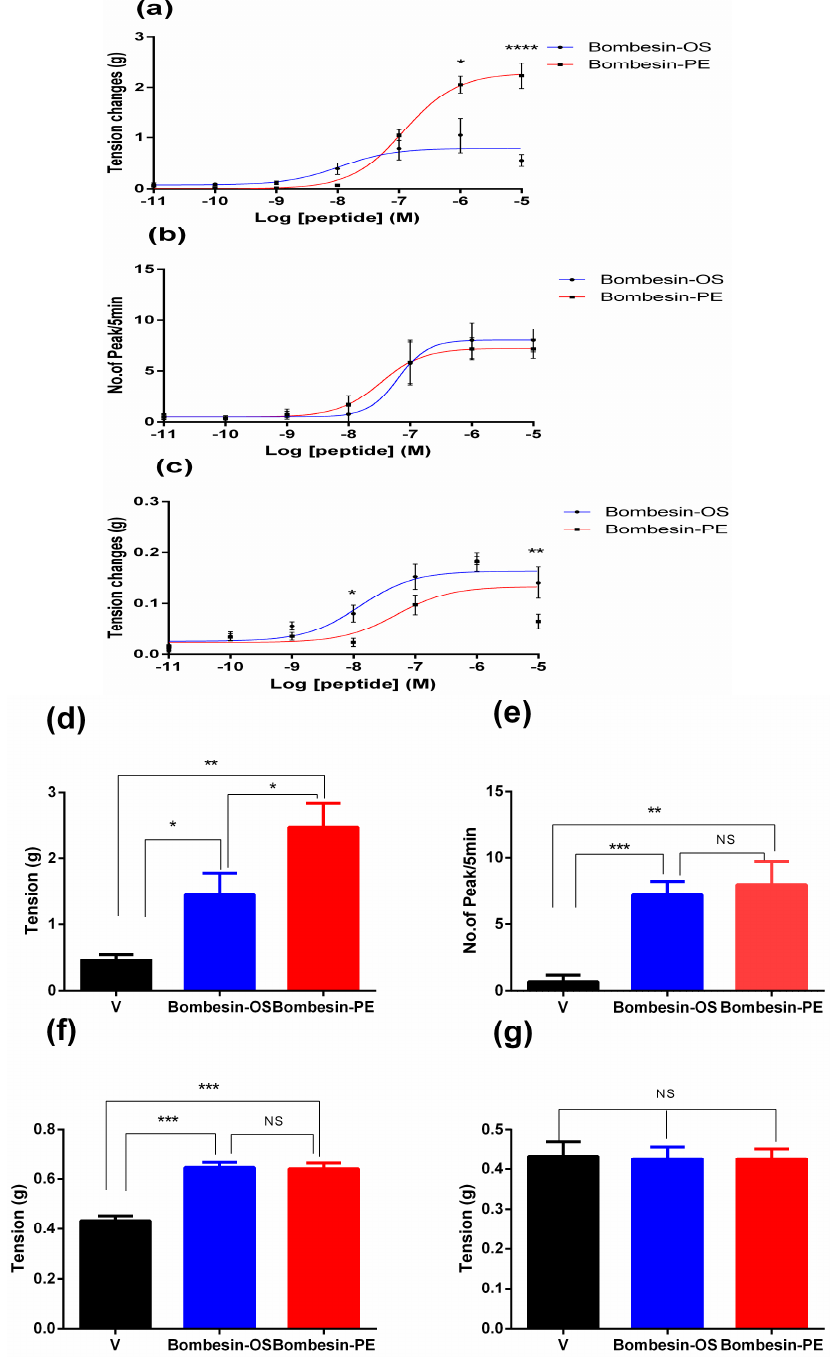
Figure 5. Comparison of myotropic effects of synthetic bombesin-OS and bombesin-PE on isolated rat urinary bladder, uterus, and ileum smooth muscles. Dose response curves of bombesin-OS and bombesin-PE actions on the smooth muscle preparations from ( a ) rat bladder (observed power b = 0.998); ( b ) rat uterus (observed power b = 1.000); and ( c ) rat ileum (observed power b = 1.000). Pharmacological effects of bombesin-OS and bombesin-PE, at 1 µM, on the smooth muscle preparations from ( d ) rat bladder [F(2,24) = 3.949); observed power b = 0.978]; ( e ) rat uterus [F(2,24) = 8.047; observed power b = 0.973]; ( f ) rat ileum [F(2,24) = 8.388); observed power b = 1.000] and ( g ) rat artery [F(2,23) = 0.01791; observed power b = 0.875]. Data represent means ± SEM of three independent experiments with nine replicates; NS represents no significant difference; V represents vehicle control. **** p < 0.0001, *** p < 0.001, ** p < 0.01 and * p < 0.05 indicate significant difference.